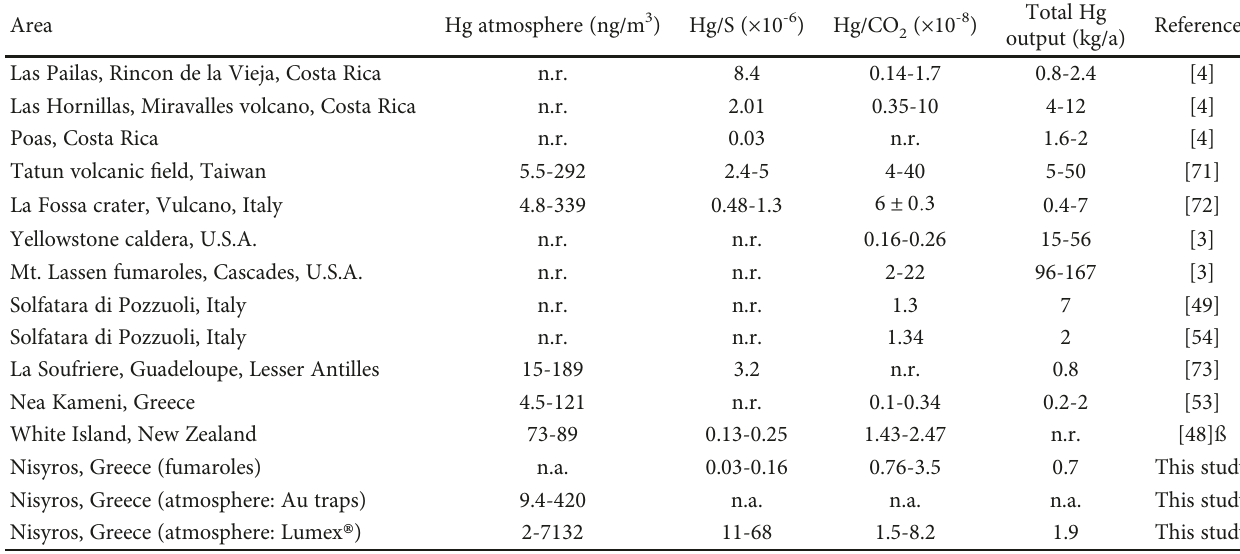
ratios, and total Hg outputs of fumarolic fi elds at closed-conduit volcanic 2